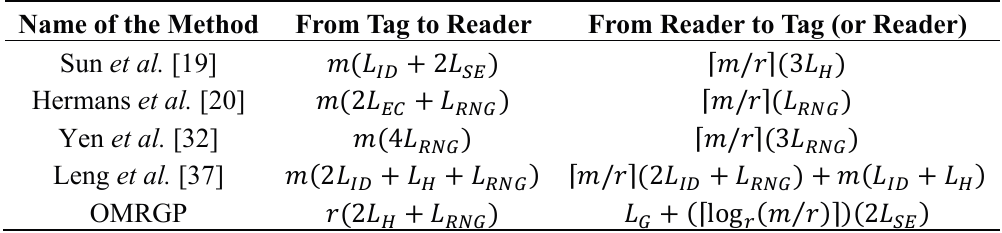
Table 5. Transmission capacity of m grouping proof